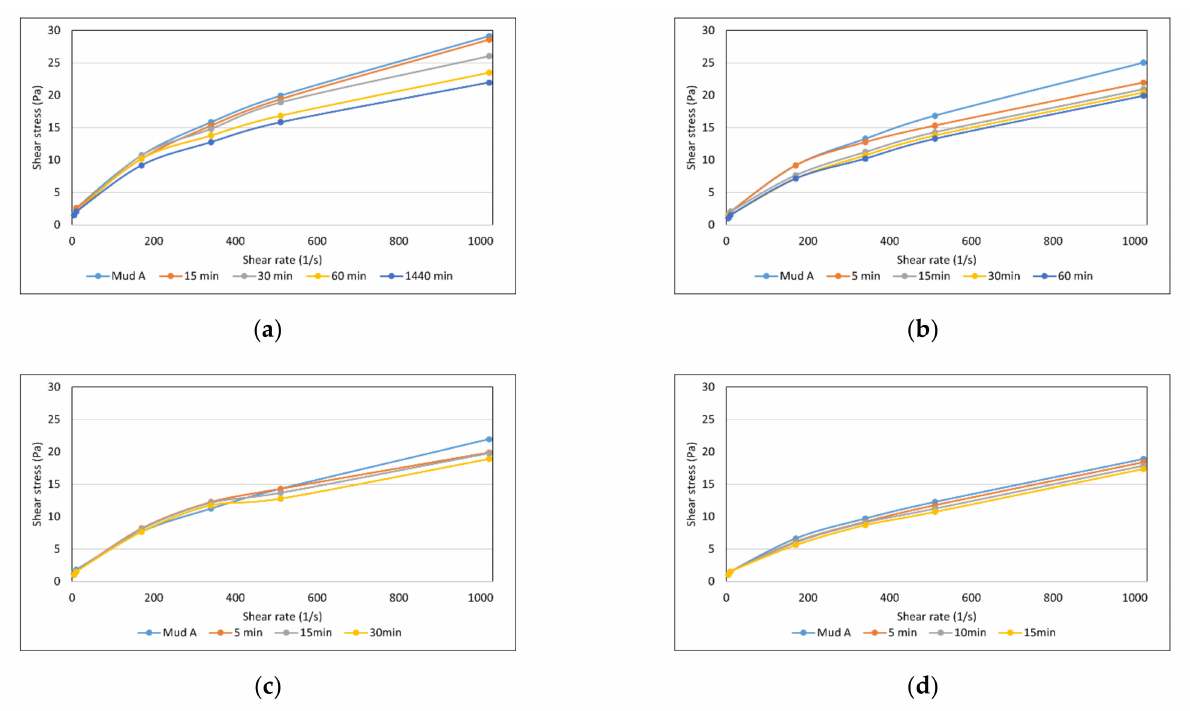
Figure 3. Flow curves of drilling mud A with 1.0% sodium persulfate: ( a ) at 20 ◦ C, ( b ) at 40 ◦ C, ( c ) at 60 ◦ C, ( d ) at 80 ◦ C.